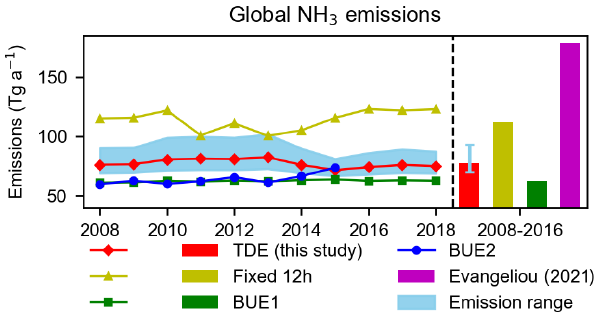
Figure 5. Comparison of our top-down NH 3 emission estimates (TDE) with other top-down (“Fixed 12h” and “Evangeliou et al. (2021)”) and bottom-up (“BUE1” and “BUE2”) results during 2008–2018. The red line and red bar represent central estimates of the TDE, and the blue shaded area and the blue error bar indicate the uncertainty evaluated by our study (Sect. 2.4).